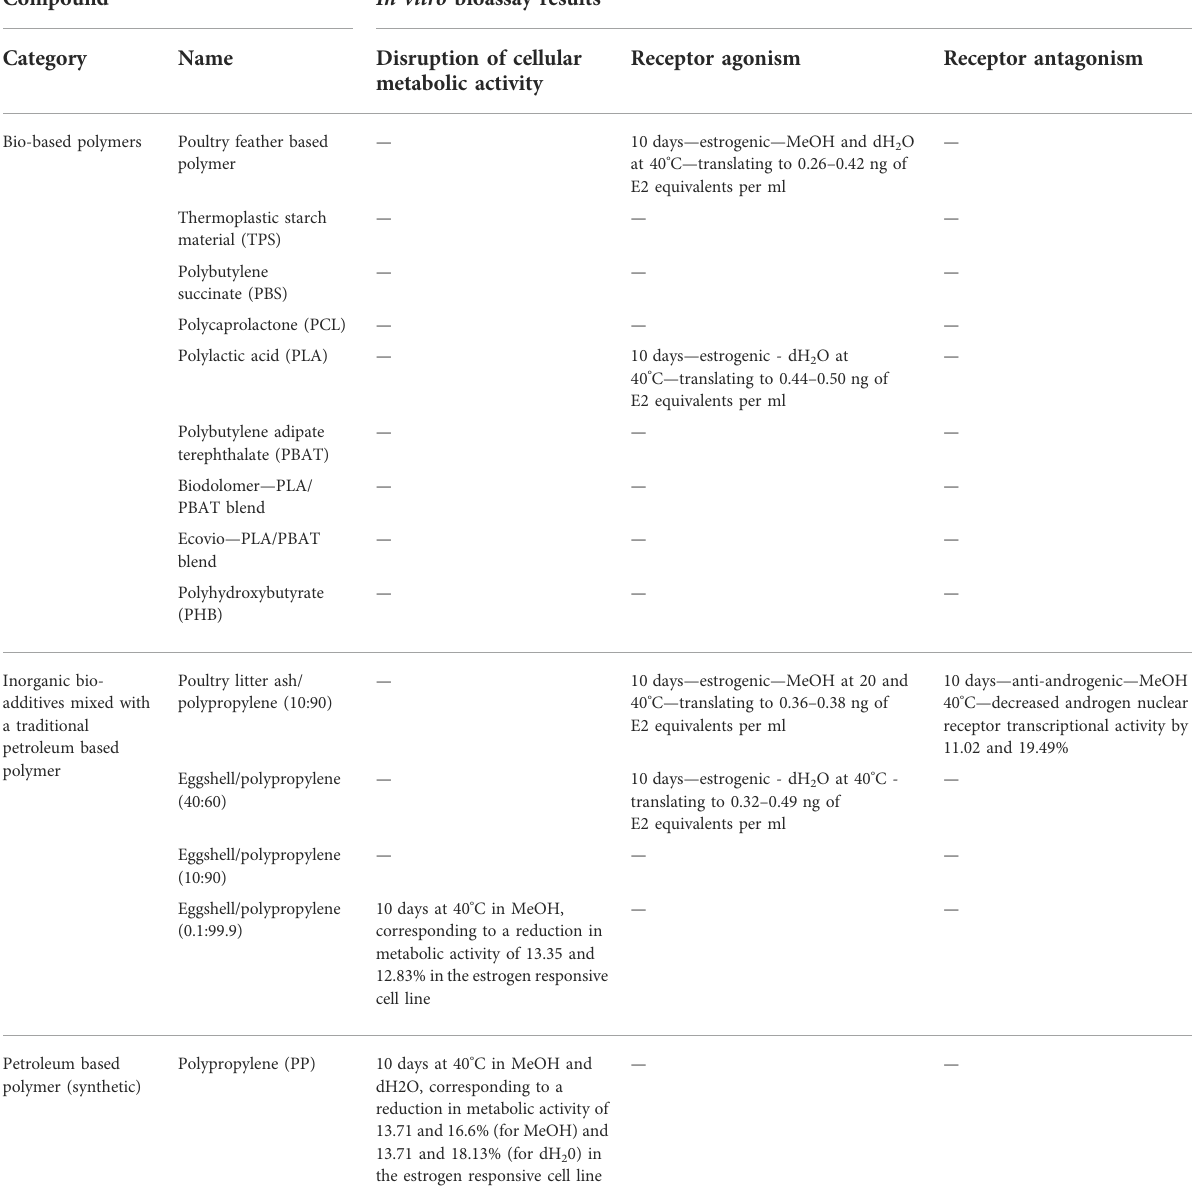
TABLE 7 Summary of results in the in vitro bioassay testing of all the migration test samples and mixes, including cytotoxic/metabolic effects, hormonal activity and calculated E2 equivalent quantities (EEQs). Compound In vitro bioassay results